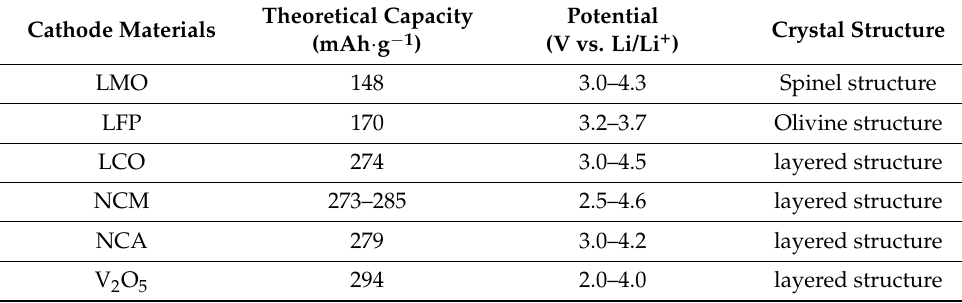
Table 1. Related parameters of common cathode